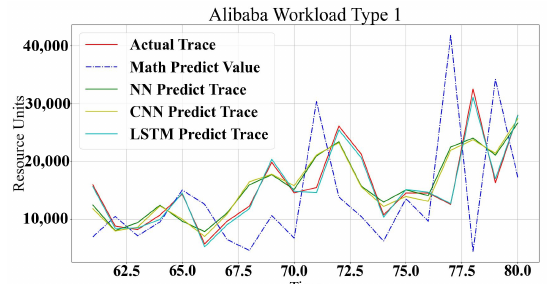
Figure 13. Google Data Center Provision Resources for WL2.